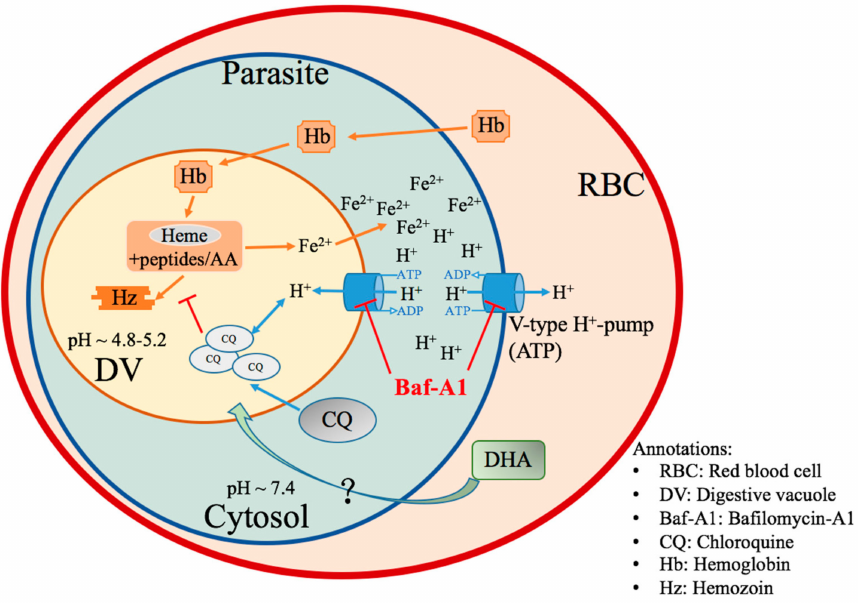
Figure 1. The mechanisms of antimalarial drugs chloroquine (CQ) / dihydroartemisinin (DHA) and V-ATPase inhibitor Baf-A1 on malaria parasites. Table 1. The targets of antimalarial drugs DHA / CQ and V-ATPase inhibitor Baf-A1. Drugs